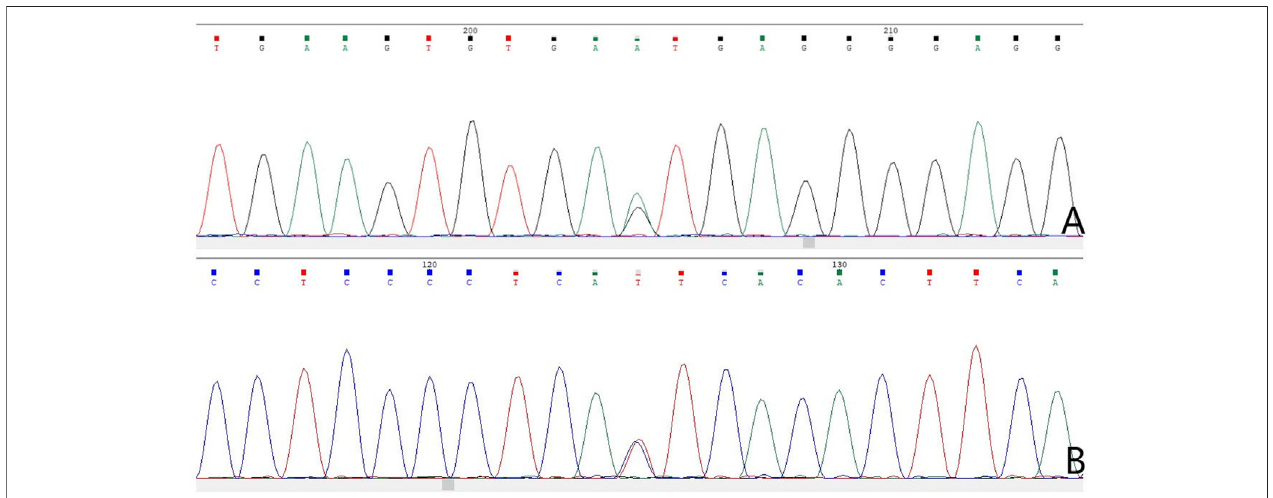
FIGURE 7 | Sanger sequencing chromatogram of CSF1R gene mutation analysis of four family members in the second family. Sequencing chromatograms identi fi ed a novel heterozygous mutation in the CSF1R gene on chromosome 5q32: a splicing mutation (c.1858+5G > A) in intron 13 of CSF1R in the proband (A) and patient Ⅱ -4 (B) .